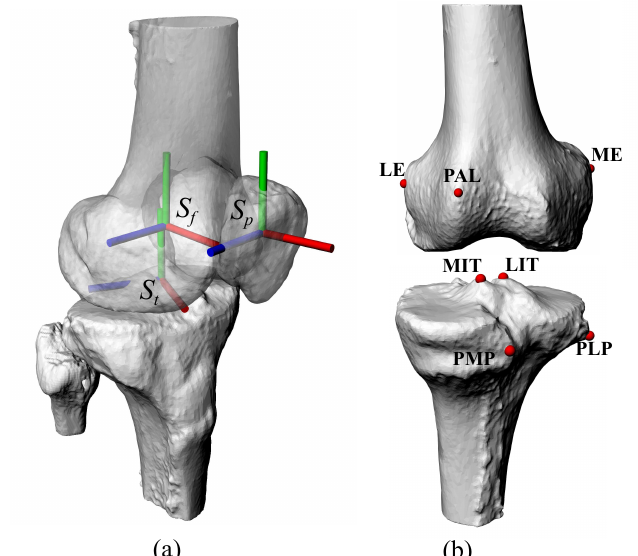
Figure 1. Figure ( a ) shows an antero–lateral view of a complete knee with the anatomical reference systems S t , S f and S p [14] superimposed: the red, green and blue axes are the x, y and z axes respectively. Figure ( b ) shows the landmarks utilized for the alignment of the bone models obtained from computed tomography (CT) and magnetic resonance imaging (MRI). To ease the identification of the landmarks, a posterior view of the tibia and an anterior view of the femur are shown. On the femur: lateral epicondyle (LE), medial epicondyle (ME), peak of the lateral anterior ridge (PAL). On the tibia: lateral intercondylar tubercle (LIT), medial intercondylar tubercle (MIT), most posterior point on posterior aspect of the medial compartment (PMP), most lateral point on the posterior aspect of the lateral compartment